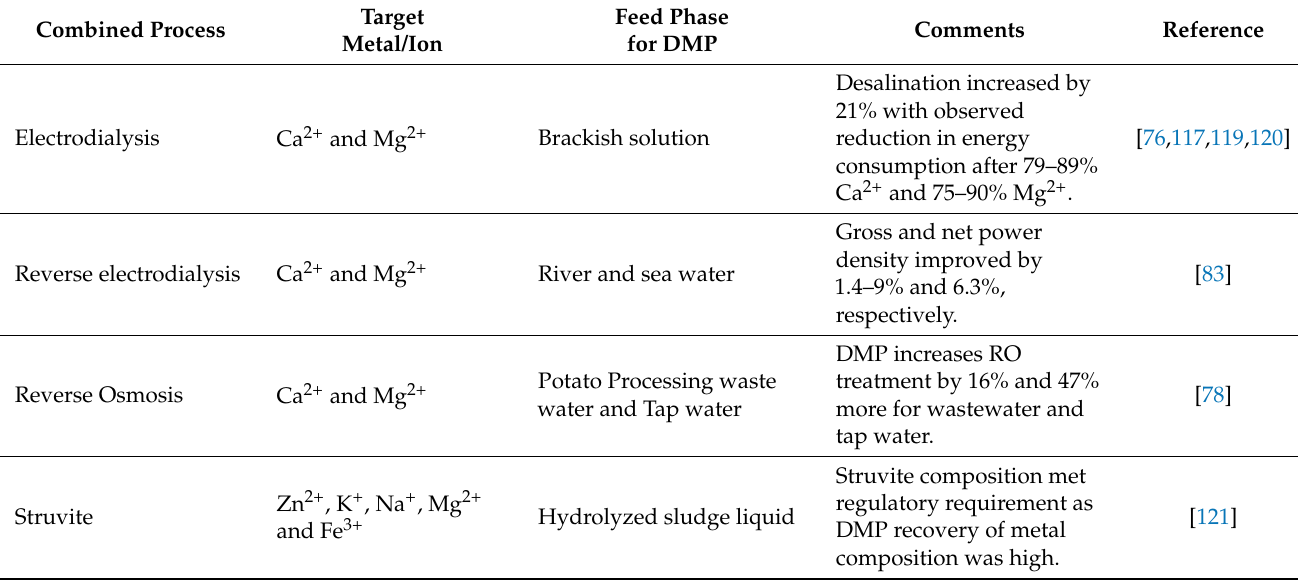
Table 4. Donnan membrane process and other treatment